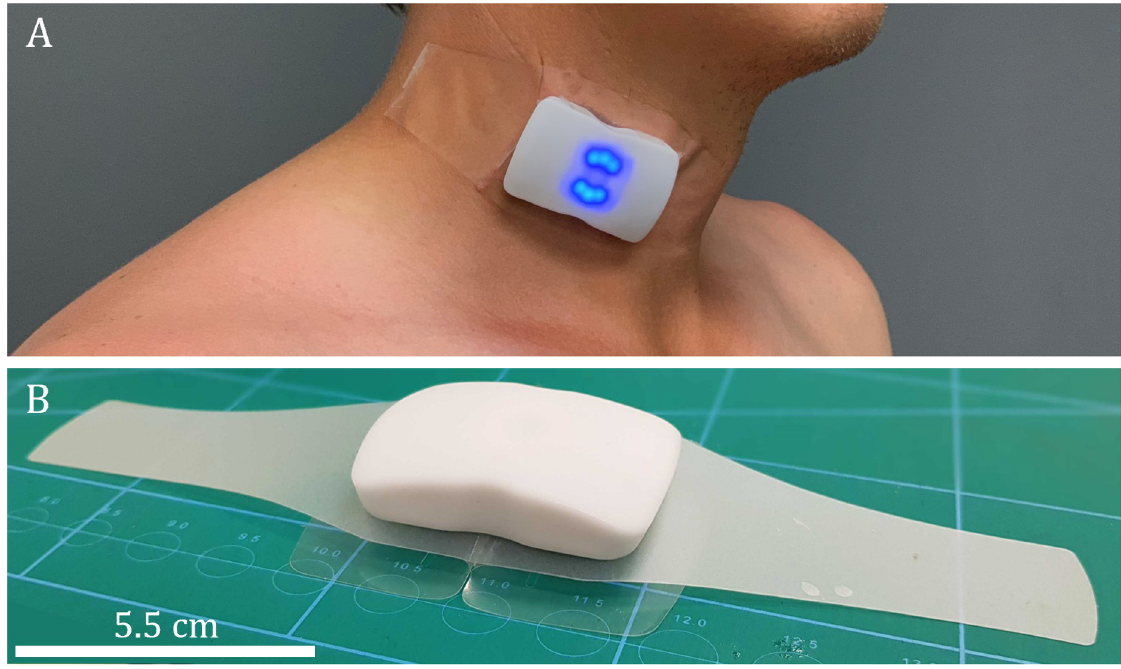
Fig 1. A and B: The wireless Doppler ultrasound